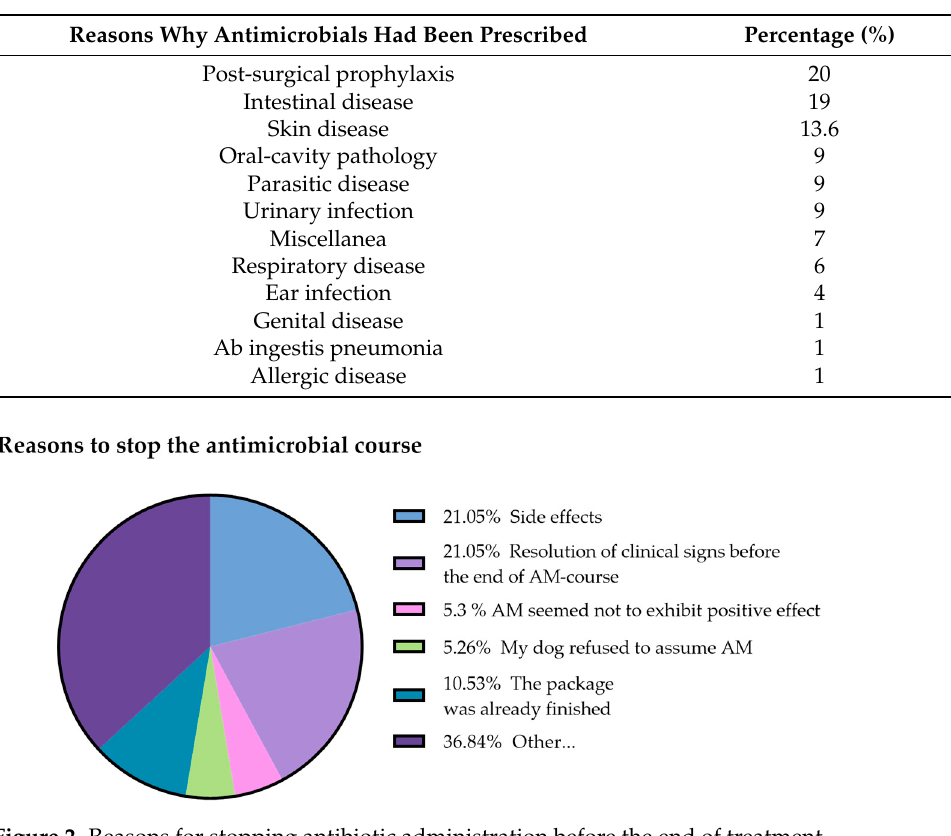
Figure 2. Reasons for stopping antibiotic administration before the end of